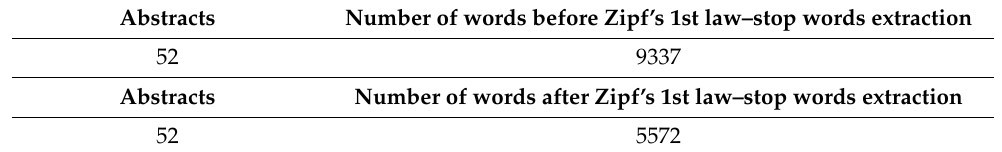
Table 1. Number of words before and after application of Zipf’s 1st